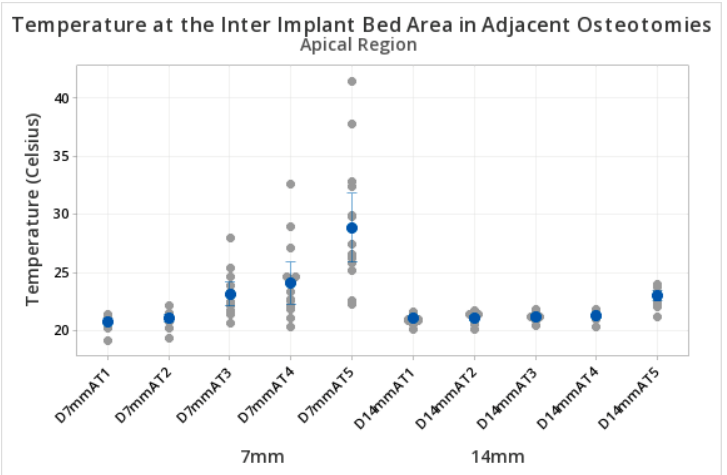
Figure 6. Temperature in the inter-osteotomy area in adjacent osteotomies. Measurements at the apical level. The y axis shows the temperature reached during the preparation of the osteotomies. The x axis indicates the different test groups at 7 mm and 14 mm inter-osteotomy area separations at the apical level. Ascending temperatures were observed in both groups, influenced by the time. D = distance, A = apical, T = time (T1 = 20 s, T2 = 40 s, T3 = 60 s, T4 = 80 s, T5 = 100 s). The blue dots represent the central mean value. The grey dots represent the distribution of upper and lower temperatures (sometimes overlapping). The blue lines if present, represent standard deviations.